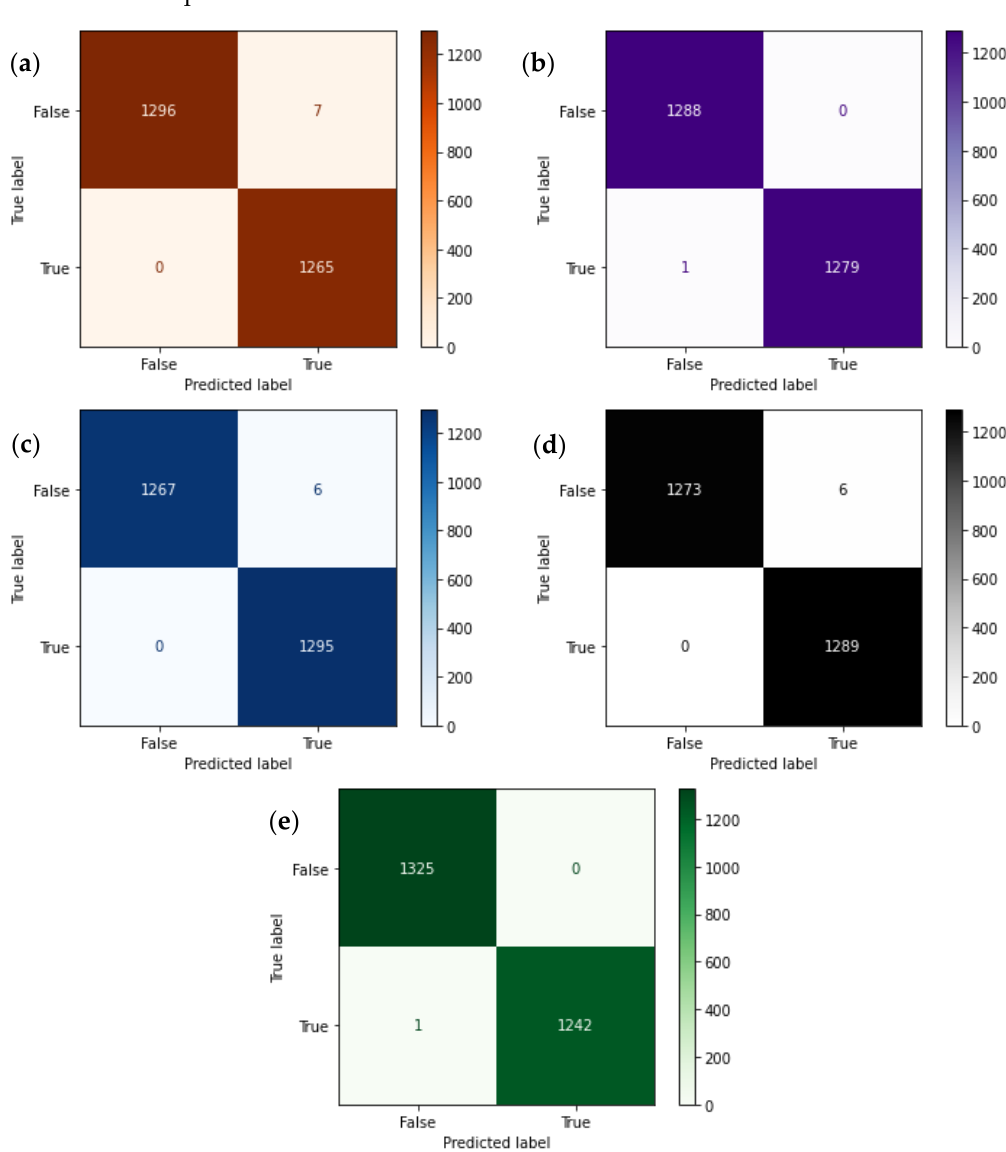
Figure 2. Confusion matrix results of DNA-mapping methods. ( a ) Atomic number, ( b ) EIIP, ( c ) Integer number, ( d ) Molecular mass, ( e ) Real number.